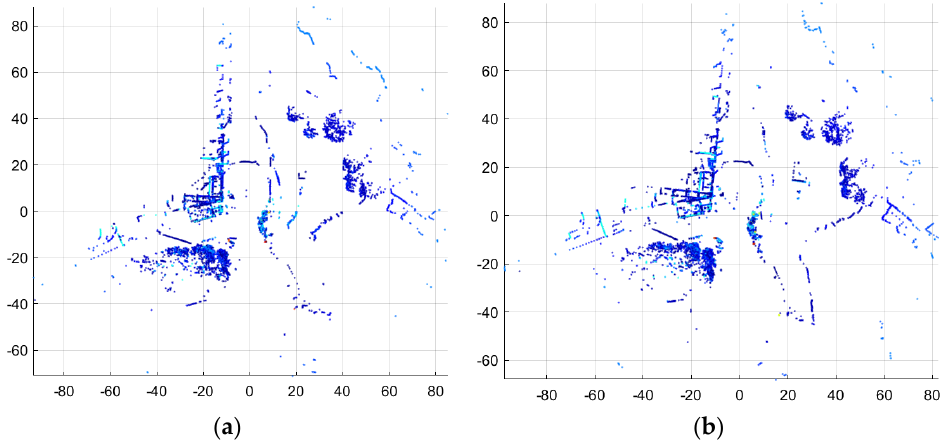
Figure 9. Scan views of two sequenced Lidar scan frames (( a ) previous scan frame; ( b ) current scan frame) for scan matching.